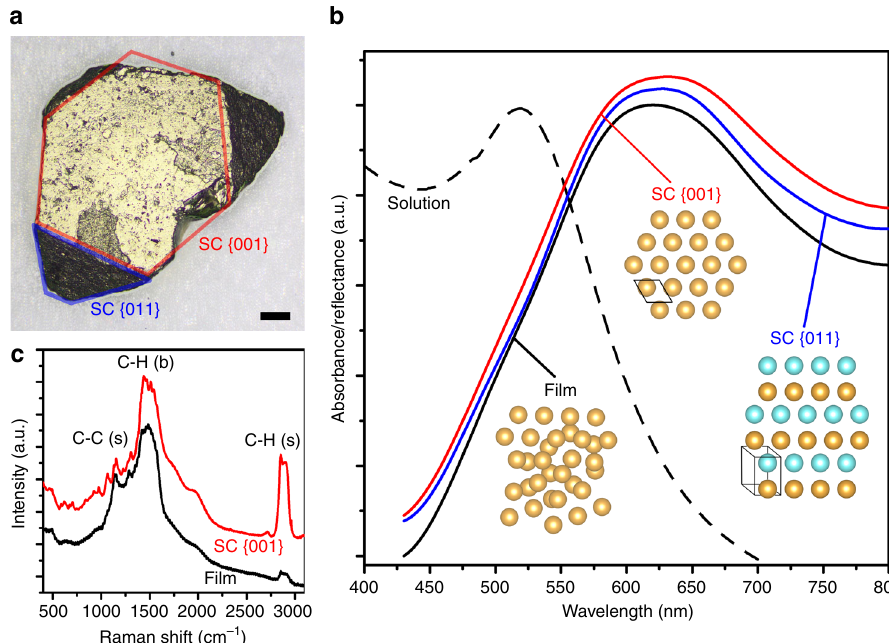
Fig. 3 Large gold SC of sub-millimeter size and optical characteristics. a Photograph of a gold SC measured 490 μ m. Scale bar is 50 μ m. The blue and red frame outline SC {011} and SC {001} surface, respectively. b Optical re fl ectance spectra (normalized) collected from two different facets (blue and red) of the SC and a drop-cast fi lm (black solid line) and absorption from the NP solution (black dashed line). c Anti-Stokes Raman spectra of dodecanethiol ligand collected from the surface of SC (red) and fi lm (black). The peaks are labeled with corresponding vibration modes with (s) = stretching and (b) = bending